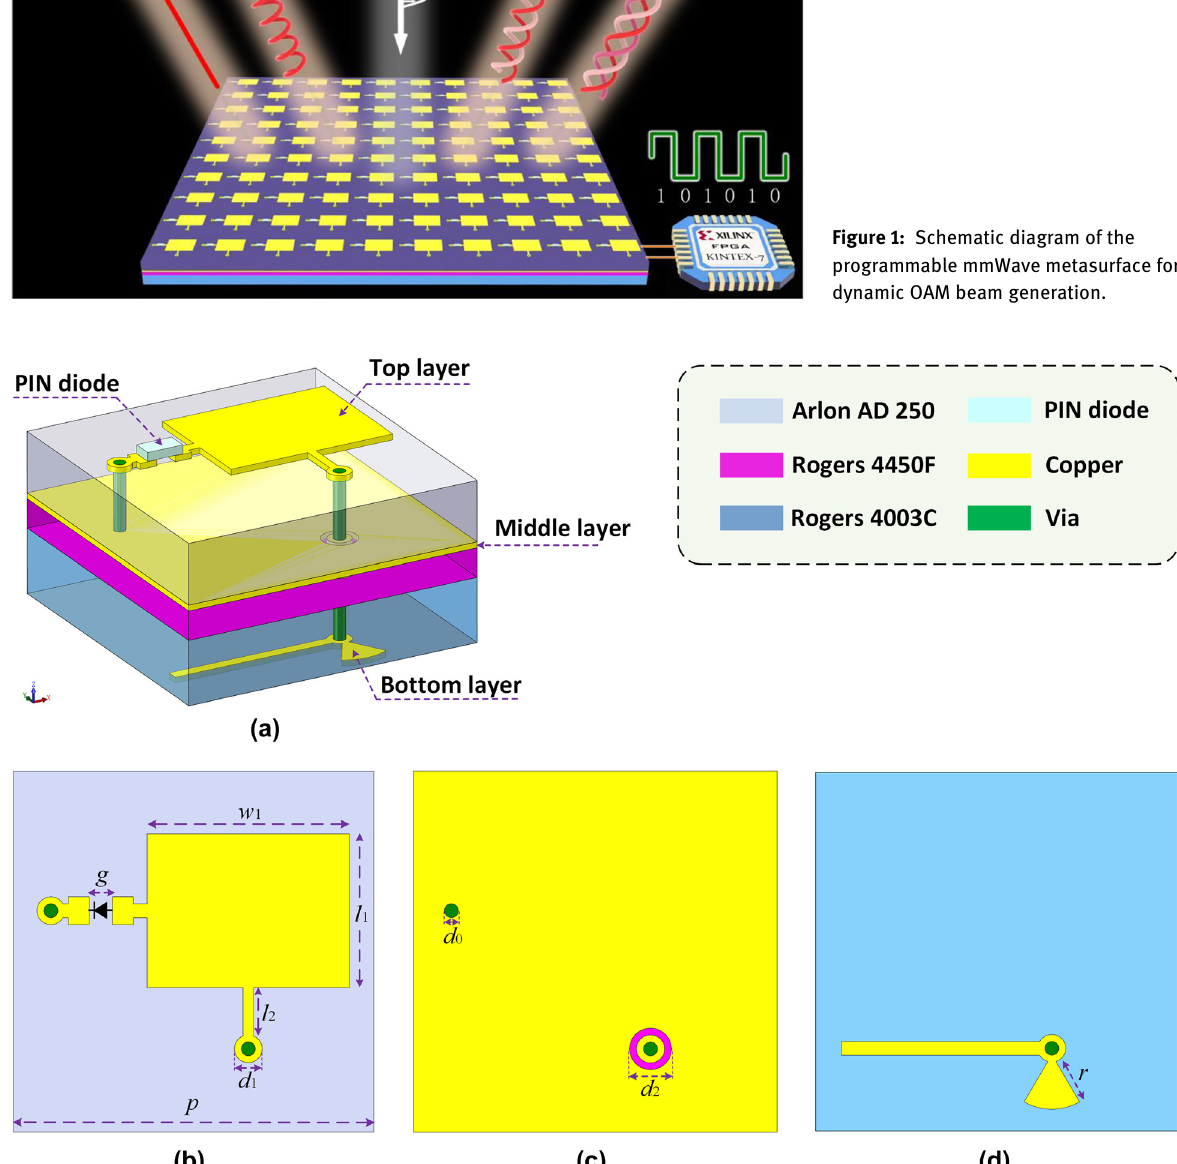
Figure 2: Topology of the reconfigurable metasurface unit. (a)3Dillustration.(b)Topradiatinglayer.(c)Middlegroundlayer.(d)Bottombias layer.The unitisdesignedat thecenterfrequencyof 29GHz with a periodicity of λ /2. Detailed parameters are as follows: p = 5.17, g = 0.33, w 1 = 2.9, l 1 = 2.2, l 2 = 0.7, d 0 = 0.2, d 1 = 0.4, d 2 = 0.5, and r = 0.68 (item: